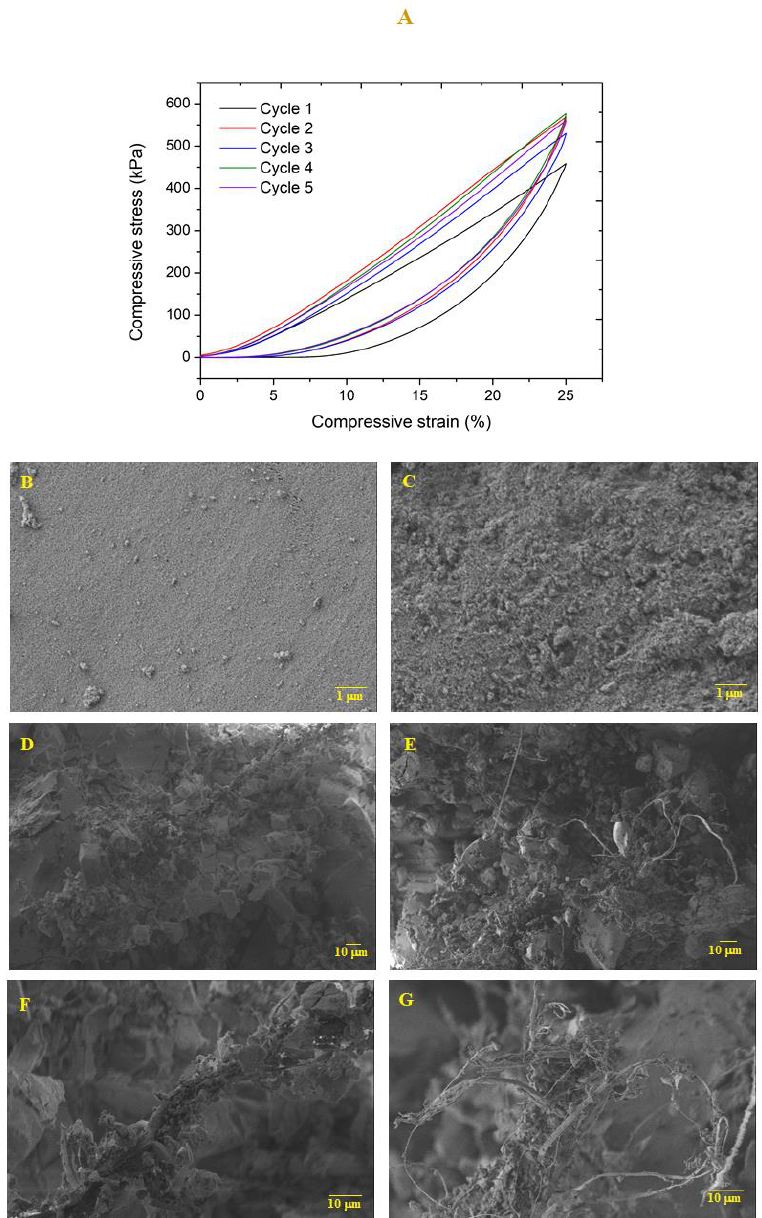
Figure 8. ( A ) Cyclic compressive test for TEOS 0.75 / VTMS 0.25 ( S = 10; KP = 6.5%). SEM images of ( B ) surface and ( D , F ) cross section before the compression test. SEM images of ( C ) surface and ( E , G ) cross section after 5 cycles of compression-decompression.